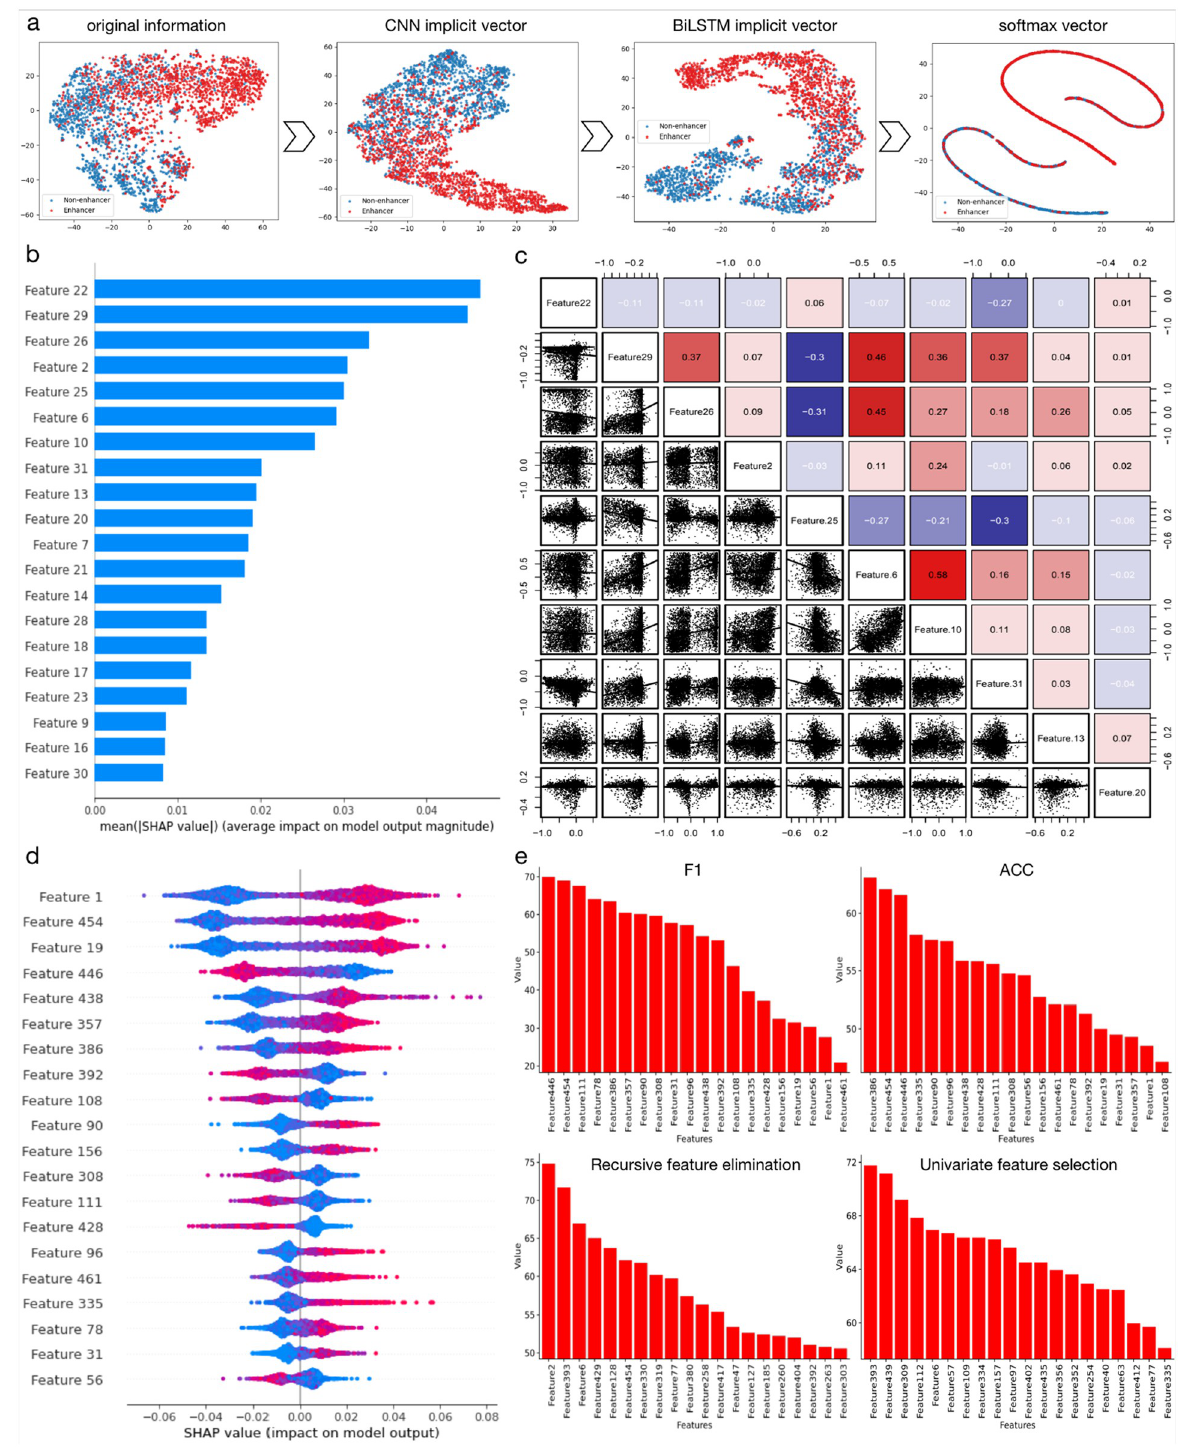
Fig 8. (a) shows the t-SNE results of deep learning-based sequence network for different hidden layers of the dynamic implicit relation and long- distance dependency process in dynamic contextual features; (b) The top 20 features of dynamic semantic information, the higher the SHAP value, the greater the influence of the feature in the classification; (c) Correlations among the top 20 features of dynamic semantic information; (d) The top 20 features of the multi-source biological features having the highest impact on classification; (e) Feature rankings for enhancer identification, where the two sub-figures above are ranked based on F1 and ACC metrics, both rankings are measured based on random forest classifier building under scikit-learn package. The two sub-figures at the bottom are ranked using RFE and UFS feature selection methods.